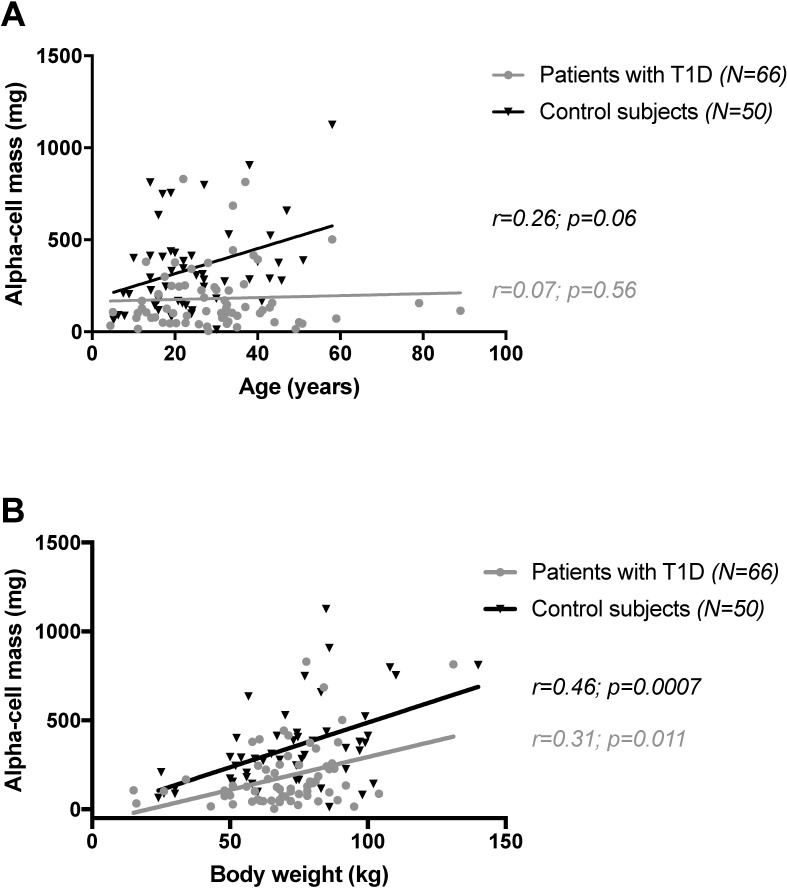
A: Correlation between α-cell mass and age in patients with T1D and control subjects. B: Correlation between α-cell mass and body weight in patients with T1D and control subjects. T1D patients are symbolized by grey circles and controls by black triangles.